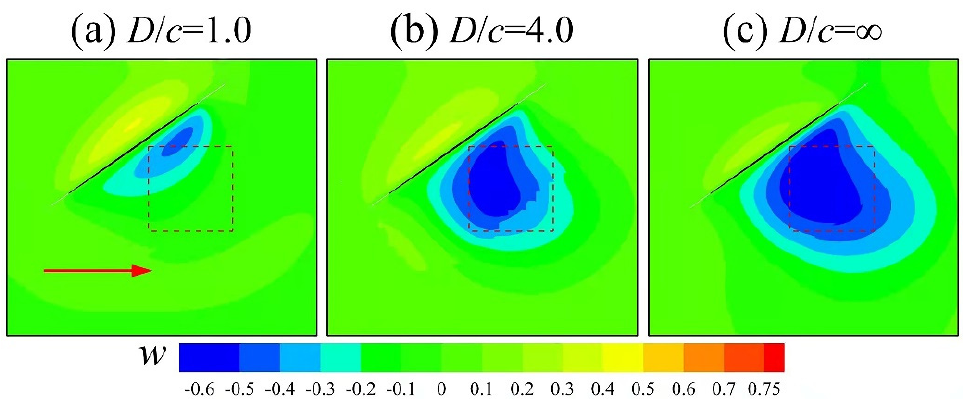
Figure 12. The vertical velocity ( w ) contours on the stroke plane (top view) at the beginning of a stroke for ( a ) D / c = 1.0; ( b ) D / c = 4.0; and ( c ) D / c = ∞ at Re = 10. The dashed boxes indicate the regions encountered by the wing at mid-stroke. The wing’s stroke direction is given by the red ar- row.